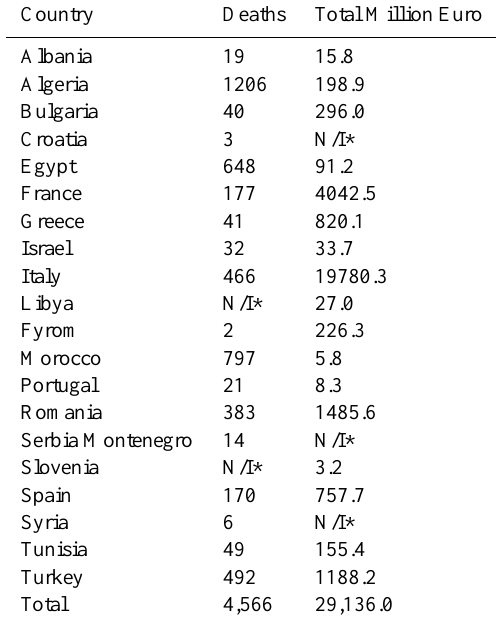
Table 2. Damages and deaths caused by floods in the Mediterranean Region from